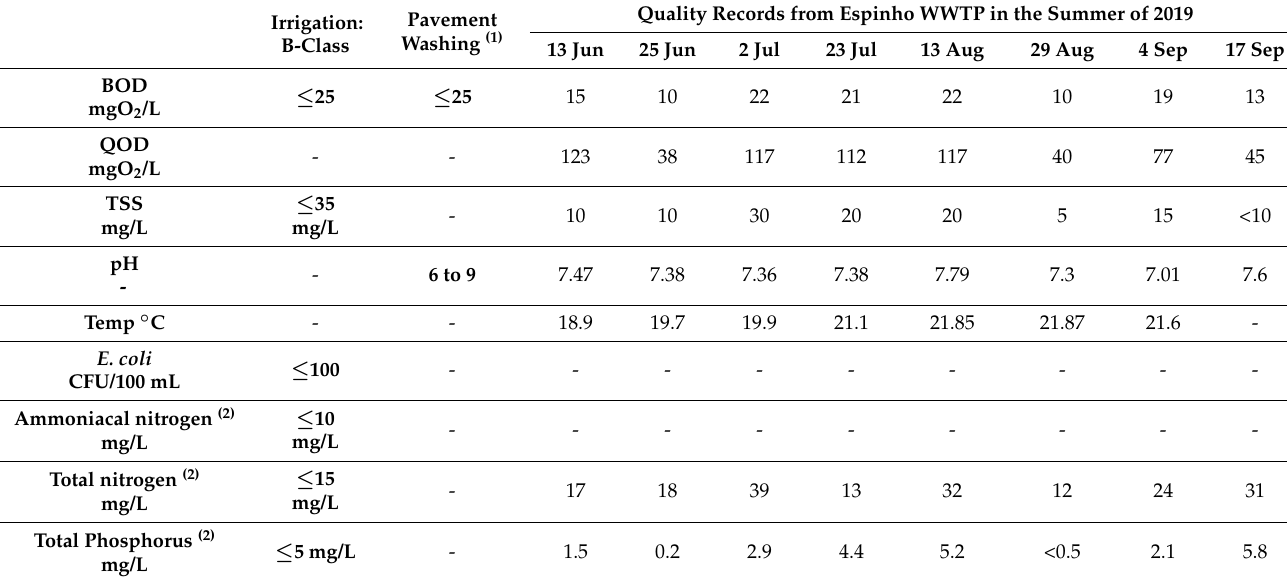
Table 6. Quality requirements for the suggested purposes and quality records of the discharged water from Espinho WWTP. Quality Records from Espinho WWTP in the Summer of 2019 Pavement Irrigation: Washing (1) B-Class 13